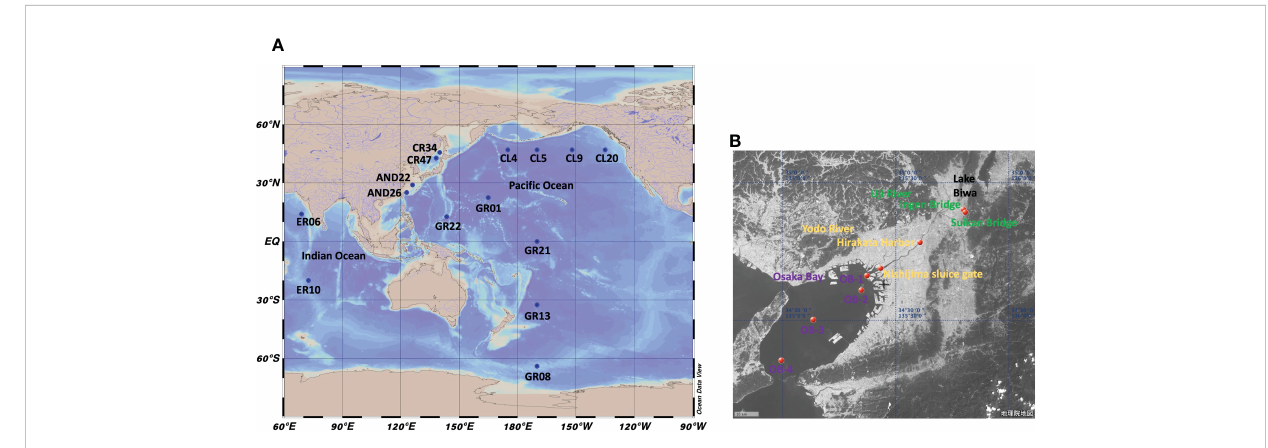
FIGURE 1 Maps showing sampling points of this study. (A) : Global map. (B) : Map of the Uji River-Yodo River-Osaka Bay